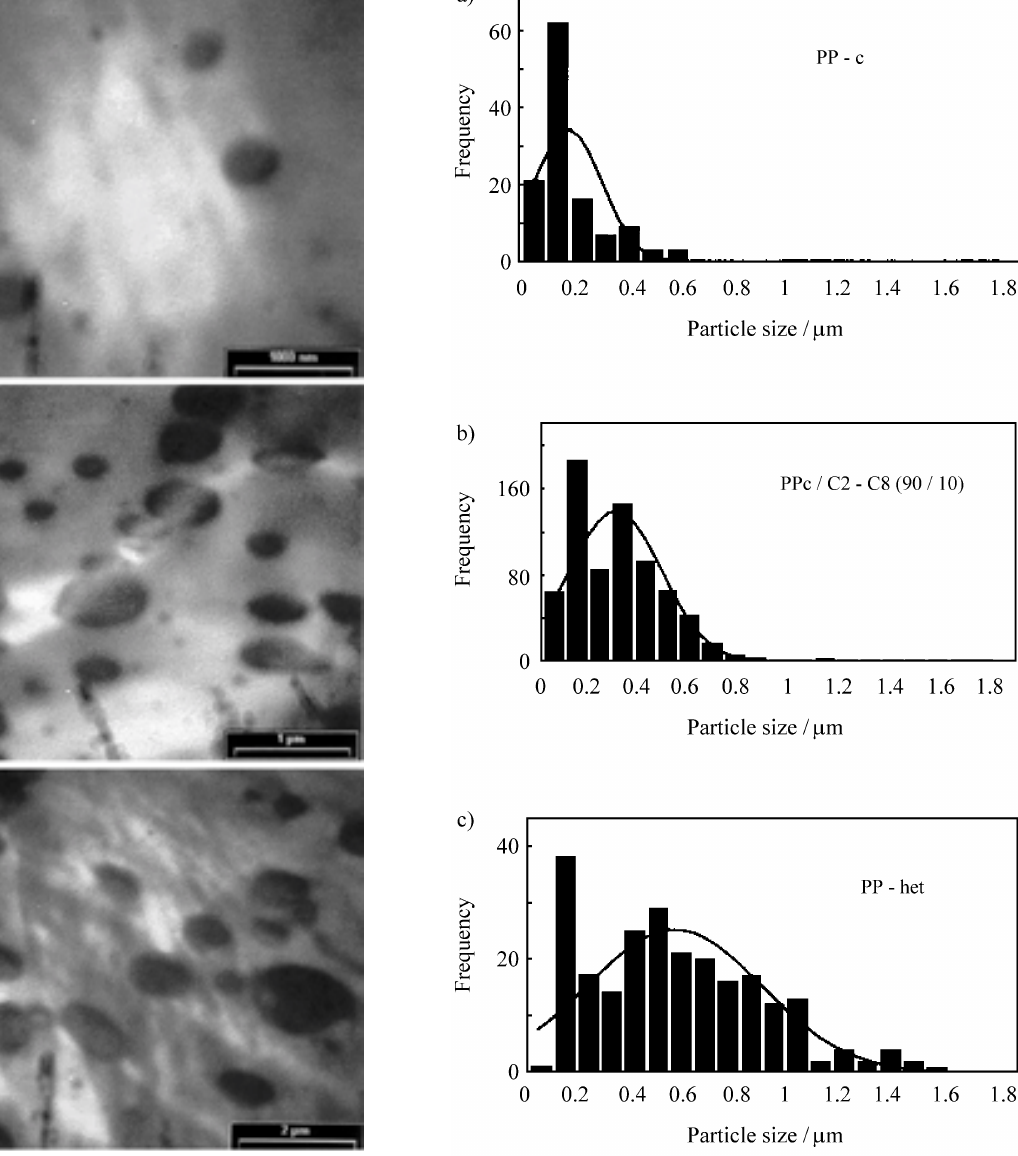
Figure 6. Morphology and histogram curves of the particle size distribution for a) PPc, b) PPcn/C 2 -C 8 (90/10) and c) PPhet. The histogram data were fitted with normal distribution